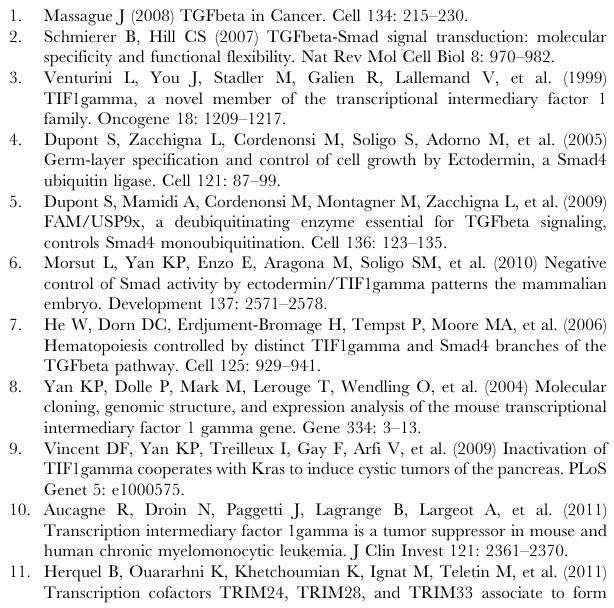
Figure S4 TIF1 c does not modify the pS24n response to a pulsed exposure to TGF- b . Model prediction of the pS24n response in the absence (A) or presence (B) of 10 nM TIF1 c to sustained TGF- b (10 nM) stimulation (blue curve), continuous short pulses at 30-minute intervals (green curve) or 3-hour intervals (red curve), as previously described experimentally (Zi et al 2011). We use 10 nM TIF1 c as an average dose of tested concentrations. Concentrations up to 50 nM TIF1 c did not modify the behavior of the signal but only reduced the signal range. Table S1 System parameters. Table S2 System of ordinary differential equations. Equations in black are from Vilar et al. , 2006 and Schmierer et al. , 2008; equations in red are estimated from biological experiments from Dupont et al ., 2005, 09 and He et al ., 2006. (PDF) Model S1 Description of the model in Systems Biology Markup Language